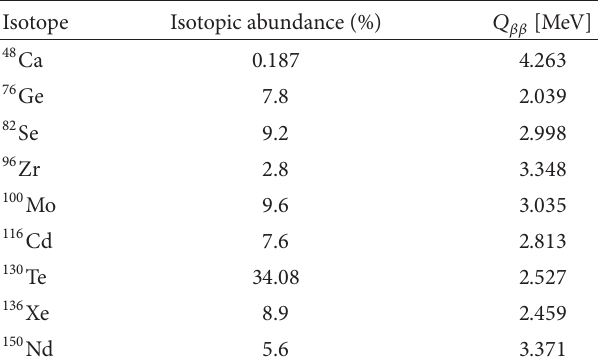
Table 5: Isotopic abundance and 𝑄 -value for the known 2 ] 𝛽𝛽 emitters [68].